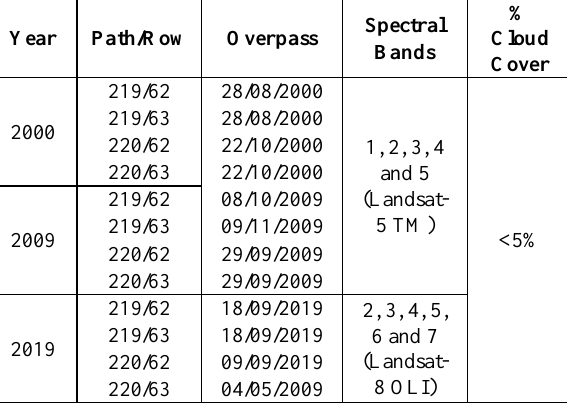
Table 1. Characteristics of the Landsat images selected for land use and land cover mapping. Source: USGS